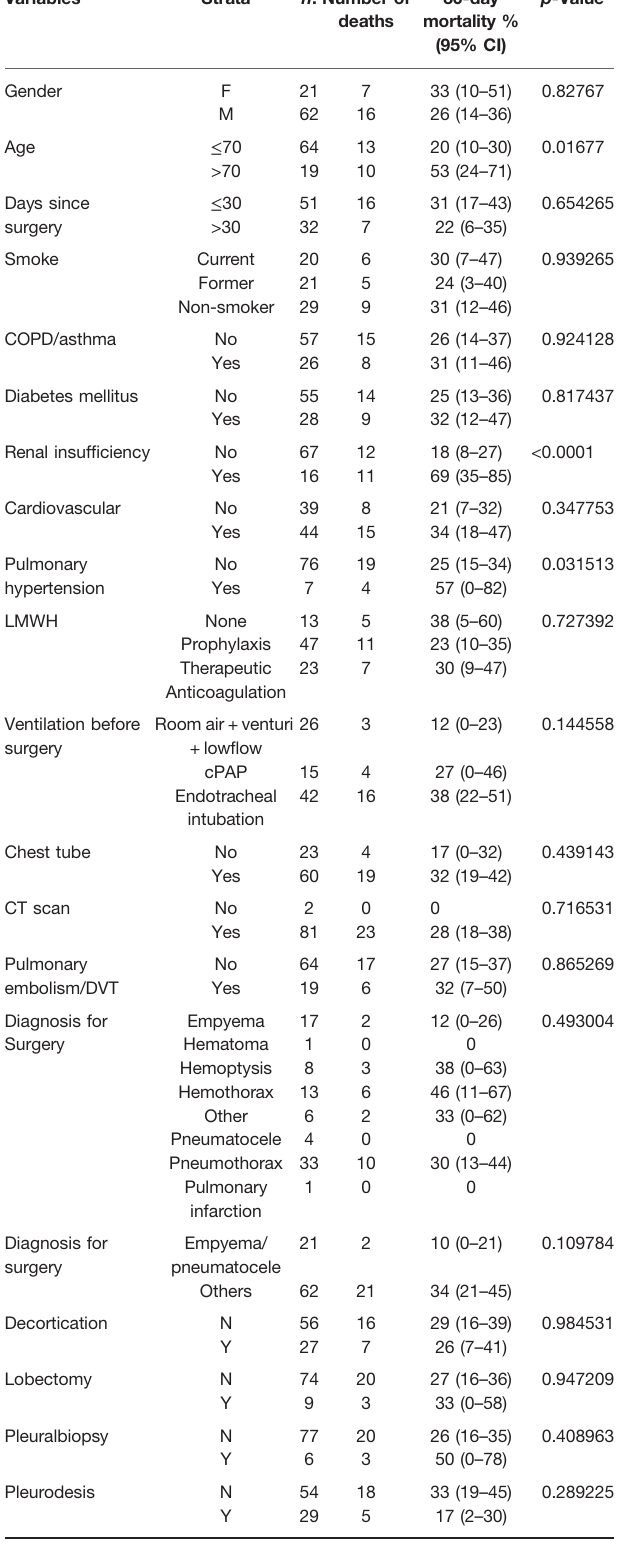
TABLE 4 | Outcomes, in terms of complications and the number of deaths, for every single pathologic affection investigated.